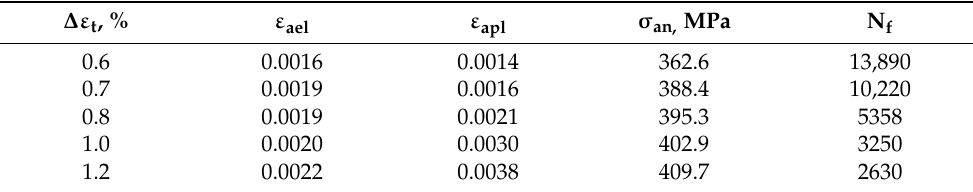
Table 2. Mechanical characteristics of HR6W alloy determined in low-cycle fatigue testing at room temperature. Δ ε t , % ε ael ε apl